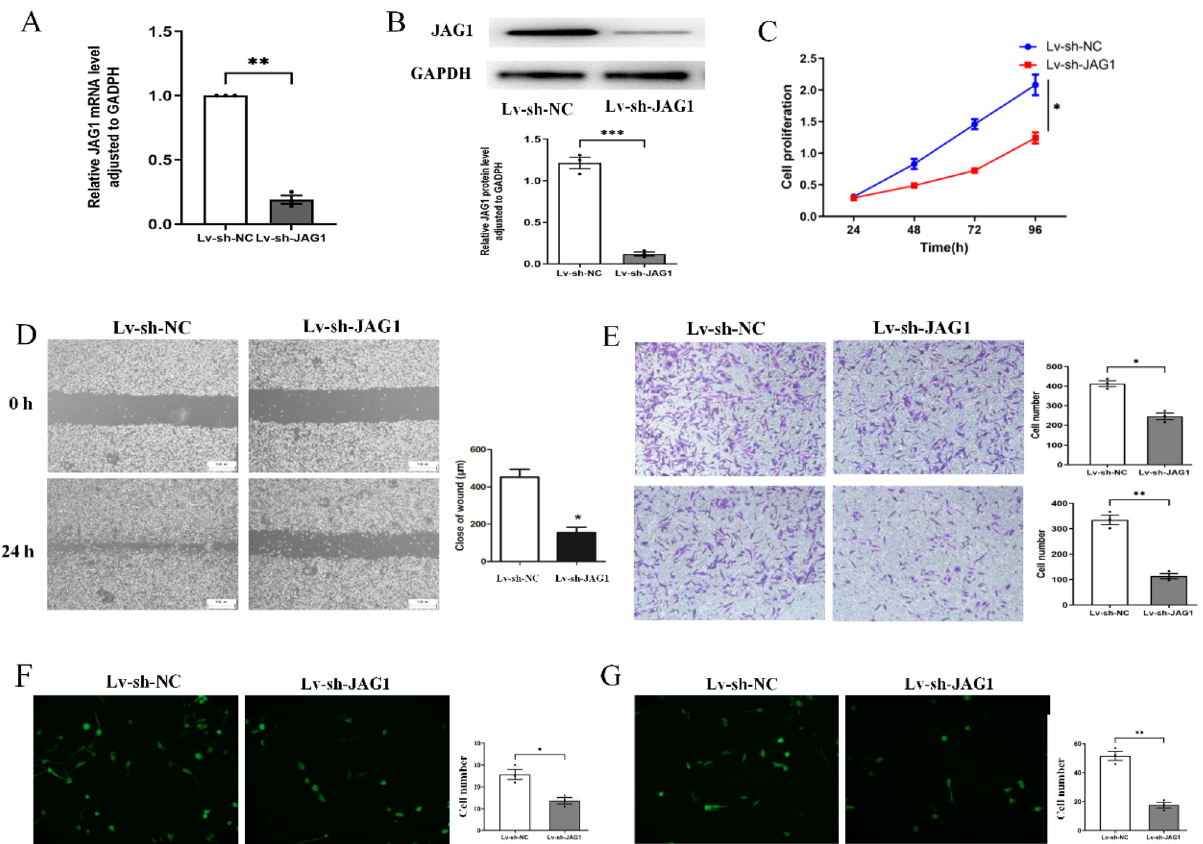
Figure 3. The influence of JAG1 knockdown on BC cells. ( A ) The JAG1 mRNA was evaluated by qPCR after JAG1 knockdown; ( B ) JAG1 protein was detected by Western Blot after JAG1 knockdown; ( C ) the proliferation of BC cells was detected by CCK-8 assay; ( D ) cell motility after JAG1 downregulation was detected by wound healing assay; ( E ) transwell assay was conducted to detect the migration (upper panels) and invasion (lower panels) of MDA-MB-231; BBB model was constructed to detect the adhesion ( F ) and penetration ( G ) abilities to